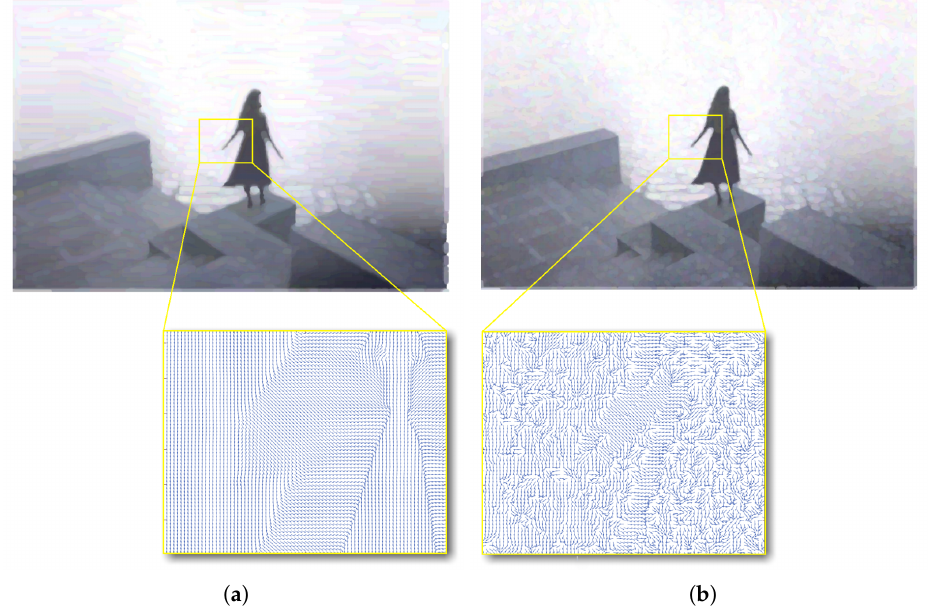
Figure 7. Edge field improvement by averaging: ( a ) a painterly rendered image using a smoothened edge field by the proposed approach; and ( b ) a rendered image with no averaging. Yellow frames highlight similar fragments of rendered images and show the underlying major eigenvectors used for brushstroke generation in each